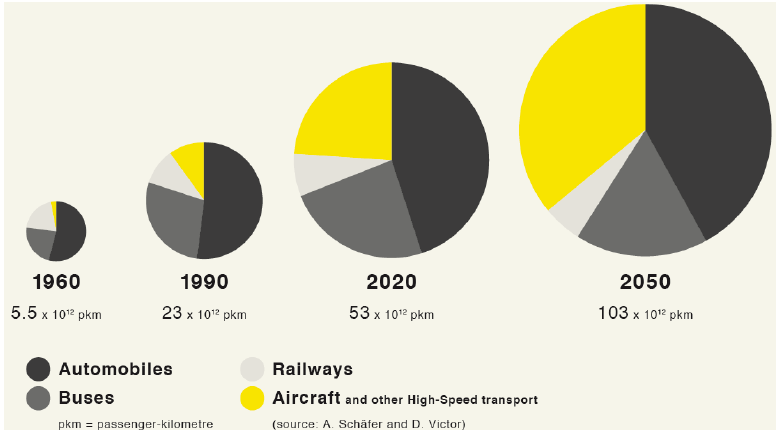
Figure 1. Historical values and future prediction of transport volumes in passenger-kilometers [6].